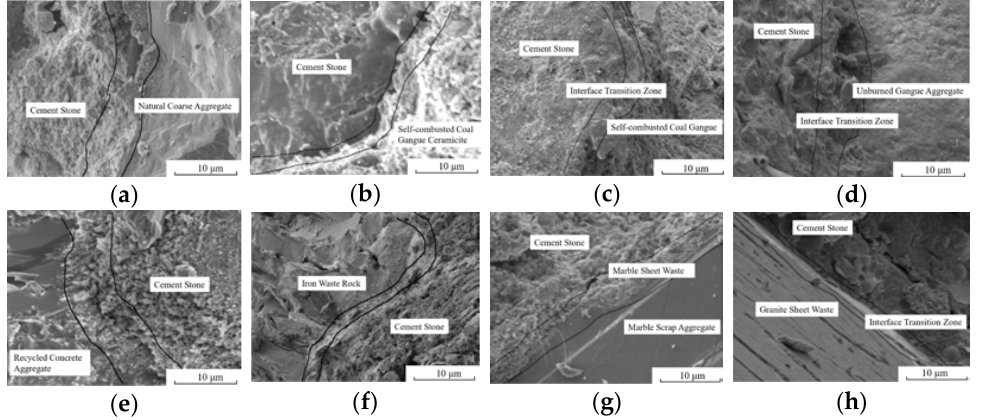
Figure 7. SEM of different kinds of coarse aggregate concrete: ( a ) NCAC; ( b ) SCCC; ( c ) SCGC; ( d ) UCGC; ( e ) RCAC; ( f ) IWRC; ( g ) MSWC; ( h ) GSWC.